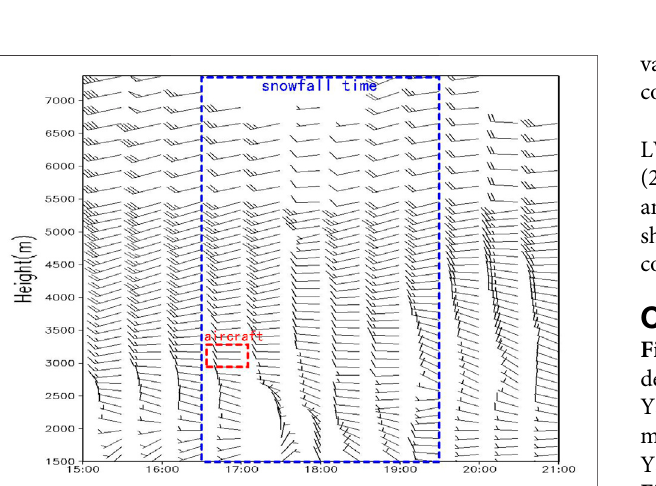
FIGURE 5 | Wind barbs observed by the wind pro fi ler radar from 1500 BJT to 2100 BJT on Jan 27, 2021 (blue box: snowfall time, red box: aircraft close to Yanjiaping time at aircraft